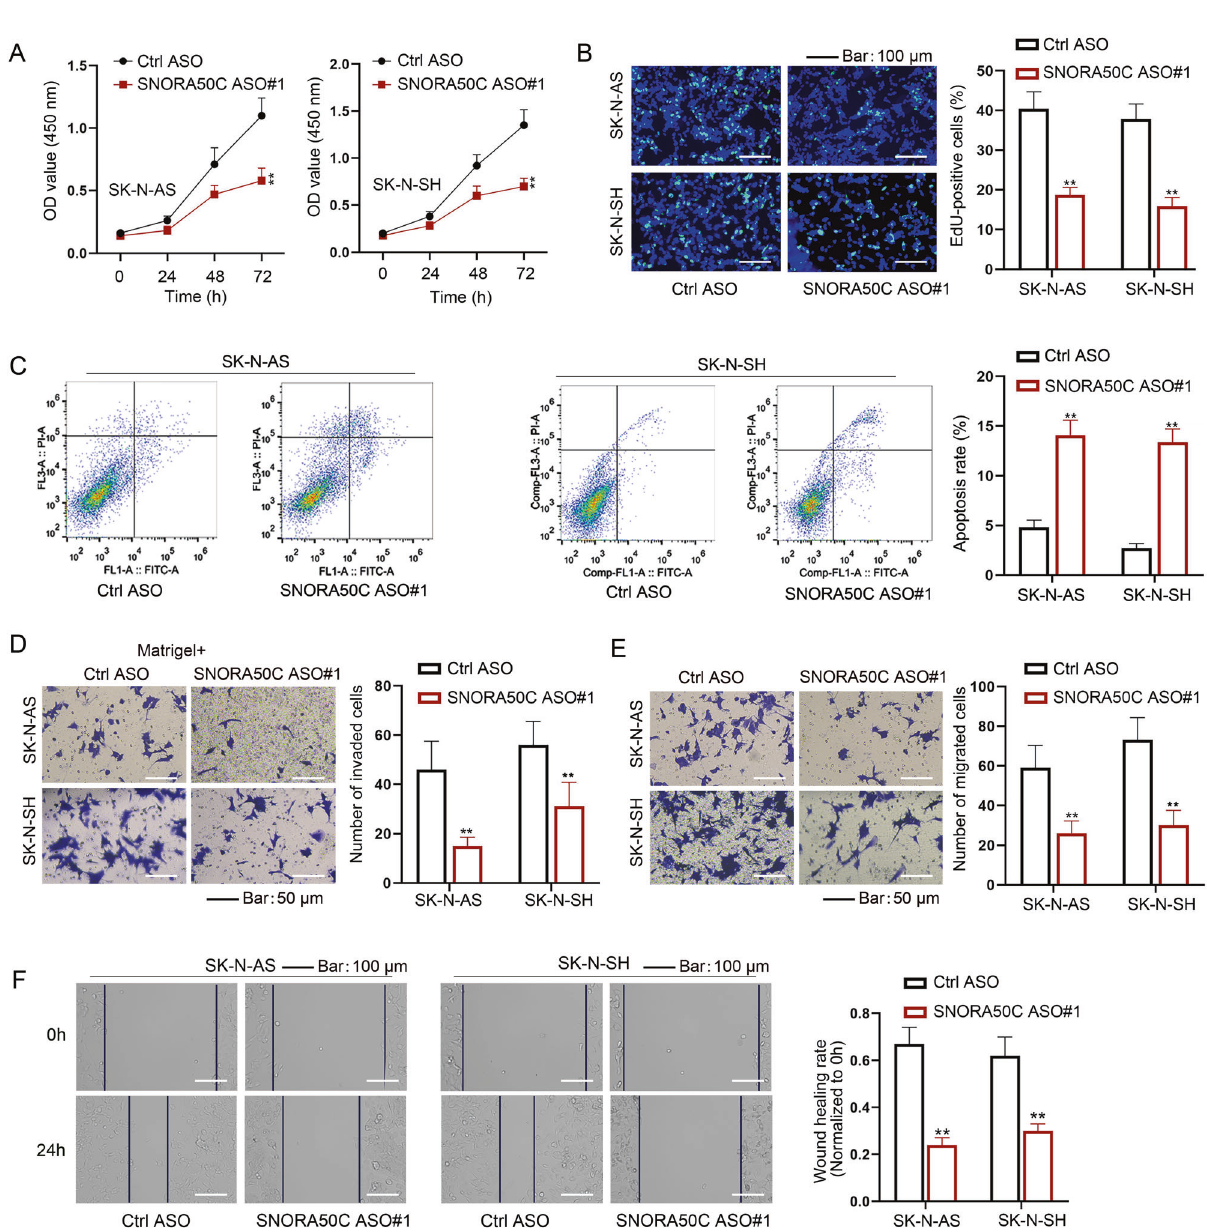
Fig. 3 SNORA50C promotes NB cell proliferation, migration, and invasion. A CCK-8 assays examined the viability of SNORA50C-inhibited NB cells. (Two-way ANOVA, Tukey) B , C Colony formation assay and fl ow cytometry analysis detected proliferation and apoptosis of NB cells